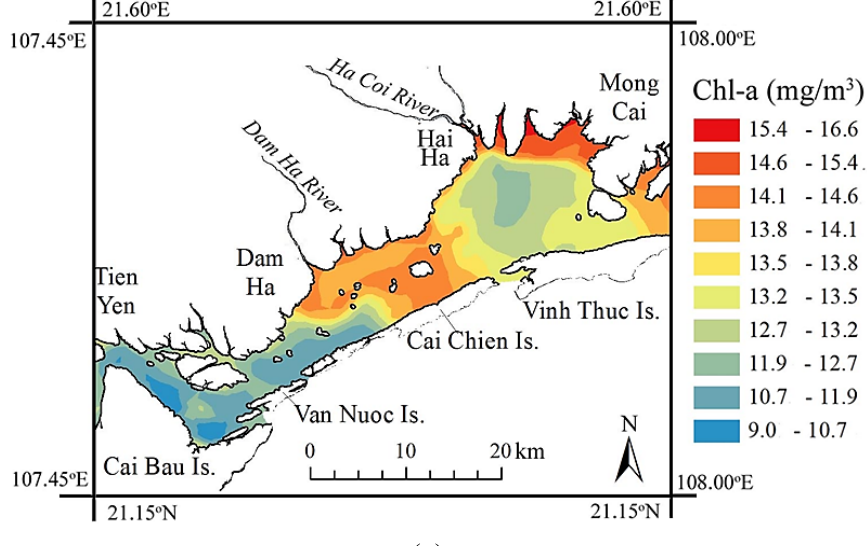
the eutrophic level, 2.21 mg/m 3 [71:Table 4]. Generally, concentrations of Chl-a over 14.5 mg/m 3 occur in local estuaries at the mouths of the Ha Coi and Dam Ha Rivers and along the coast from Mong Cai to Hai Ha. The middle bay also contains high Chl-a from 13.5 to 14.5 mg/m 3 from Cai Chien to Hai Ha districts. On the contrary, the concentrations become low toward the west near Cai Bau Island, with a minimum of 9 mg/m 3 in the channels connected with the outer sea.